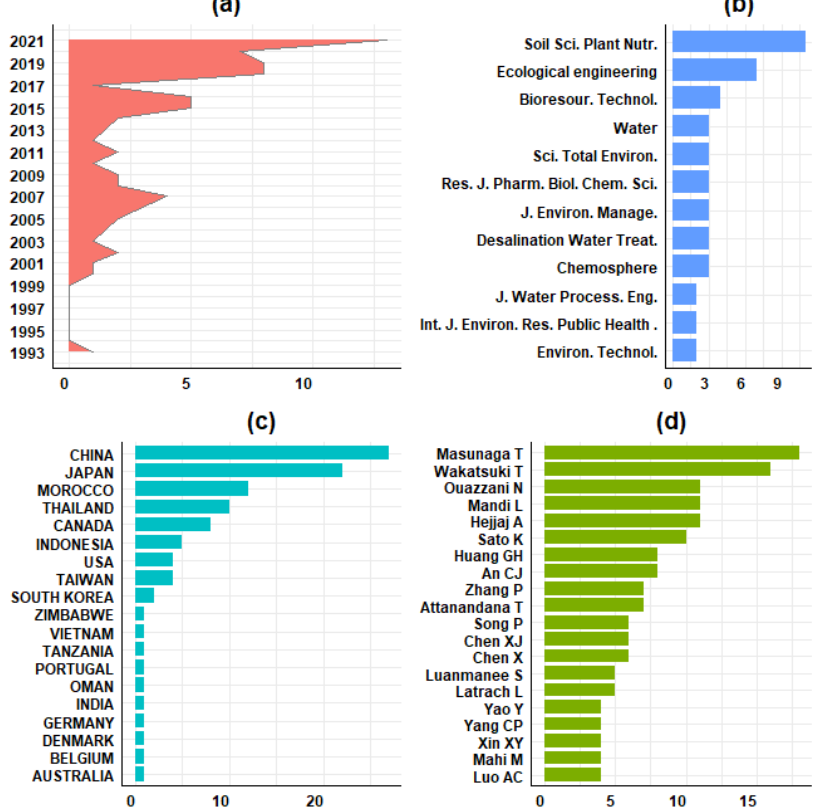
Figure 1. Quantitative analysis of MSL (Multi-Soil-Layering) publications from 1993 to 1 June 2022. ( a ) Evolution of published papers, ( b ) ranking of journals by the number of published papers, ( c ) most productive countries, ( d ) most productive researchers.